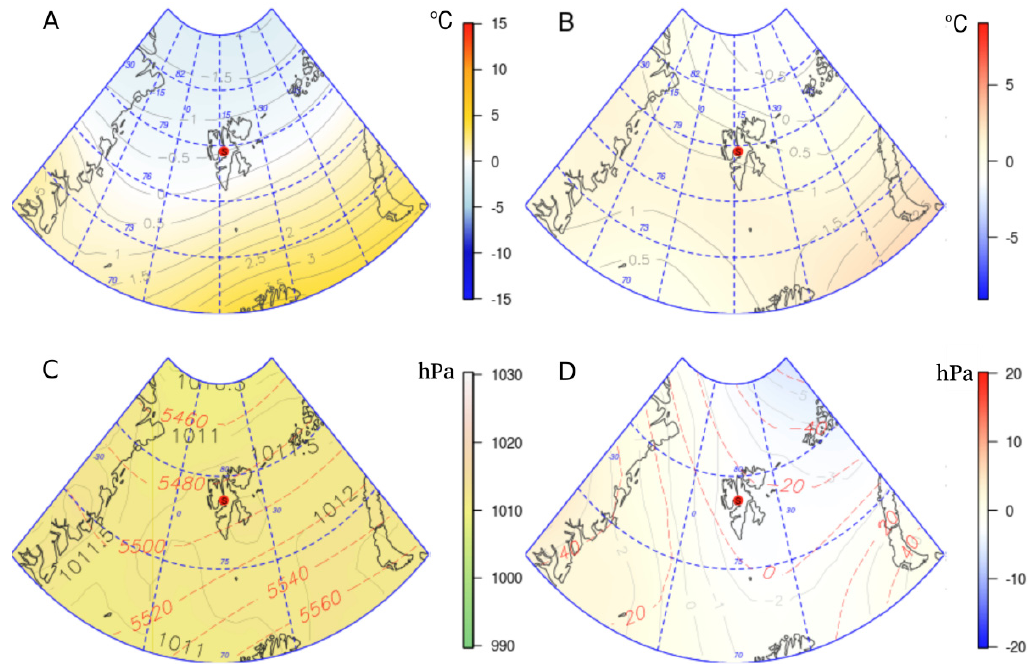
Figure 4. The average air temperature at an altitude of 850 hPa (T850) (°C)—grey solid line ( A ) and its anomalies ( B ) and the daily sea-level pressure distribution (SLP) (hPa)—grey solid line and geopotential height of 500 hPa (m)—red dotted line ( C ) and its anomalies ( D ) for the July–August 2016 period. The maps of anomalies ( B , D ) were calculated on the basis of mean values for the climatological period 1948–2016. The red point shows the research area.